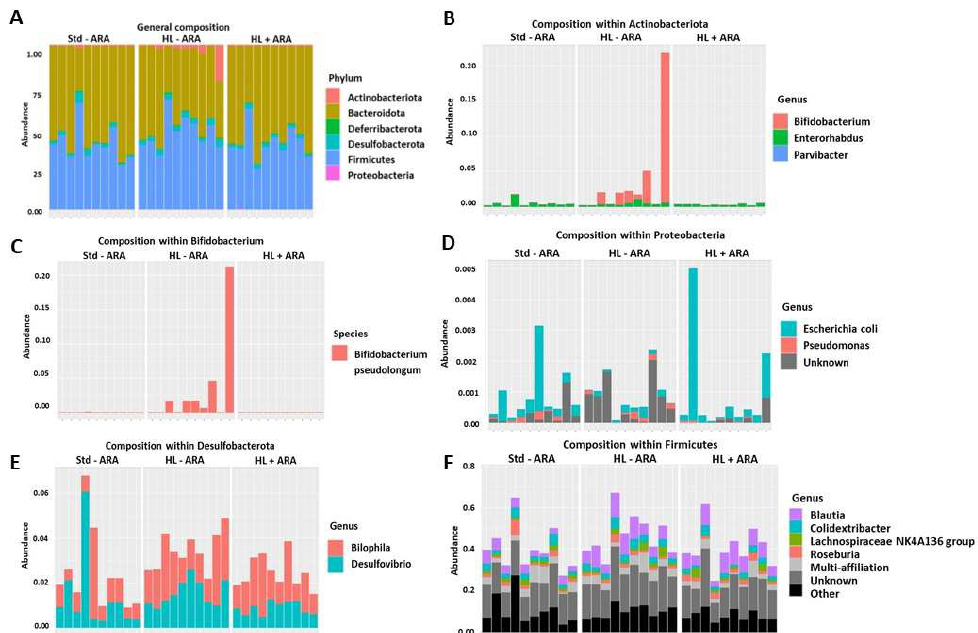
Figure 2. Fecal phylum and genus compositions of mice fed on the Std-ARA, HL-ARA, and HL + ARA diets for 9 weeks. The fecal microbiota compositions were determined on 10 mice in each group by using the V3–V4 hyper-variable region of the 16S rRNA gene. The relative abundance of the various phyla is shown in bar plot ( A ). Bar plots show the relative abundance of the various genera in the Actinobacteria ( B ), the Proteobacteria ( D ), the Desulfobacteria ( E ), and the Firmicutes ( F ) phyla. The species composition of the Bifidobacterium genus is shown in bar plot ( C ). Based on the fecal microbiota analysis of mice fed the Std-ARA, HL-ARA, and HL + ARA diets, the metabolic pathways present in the microbiota of the three mice groups Table 4. Significant differences in metabolic pathways from Kyoto Encyclopedia of Genes and were compared. The lowest number of significant differences was observed between the Genomes (KEGG) analysis of microbiota in mice fed the Std-ARA, HL-ARA, and HL + ARA diets. Std-ARA and HL + ARA groups (seven pathways with different abundances, Table 4). The type of comparison between the three groups of diet are indicated in bold in the first line and inside the